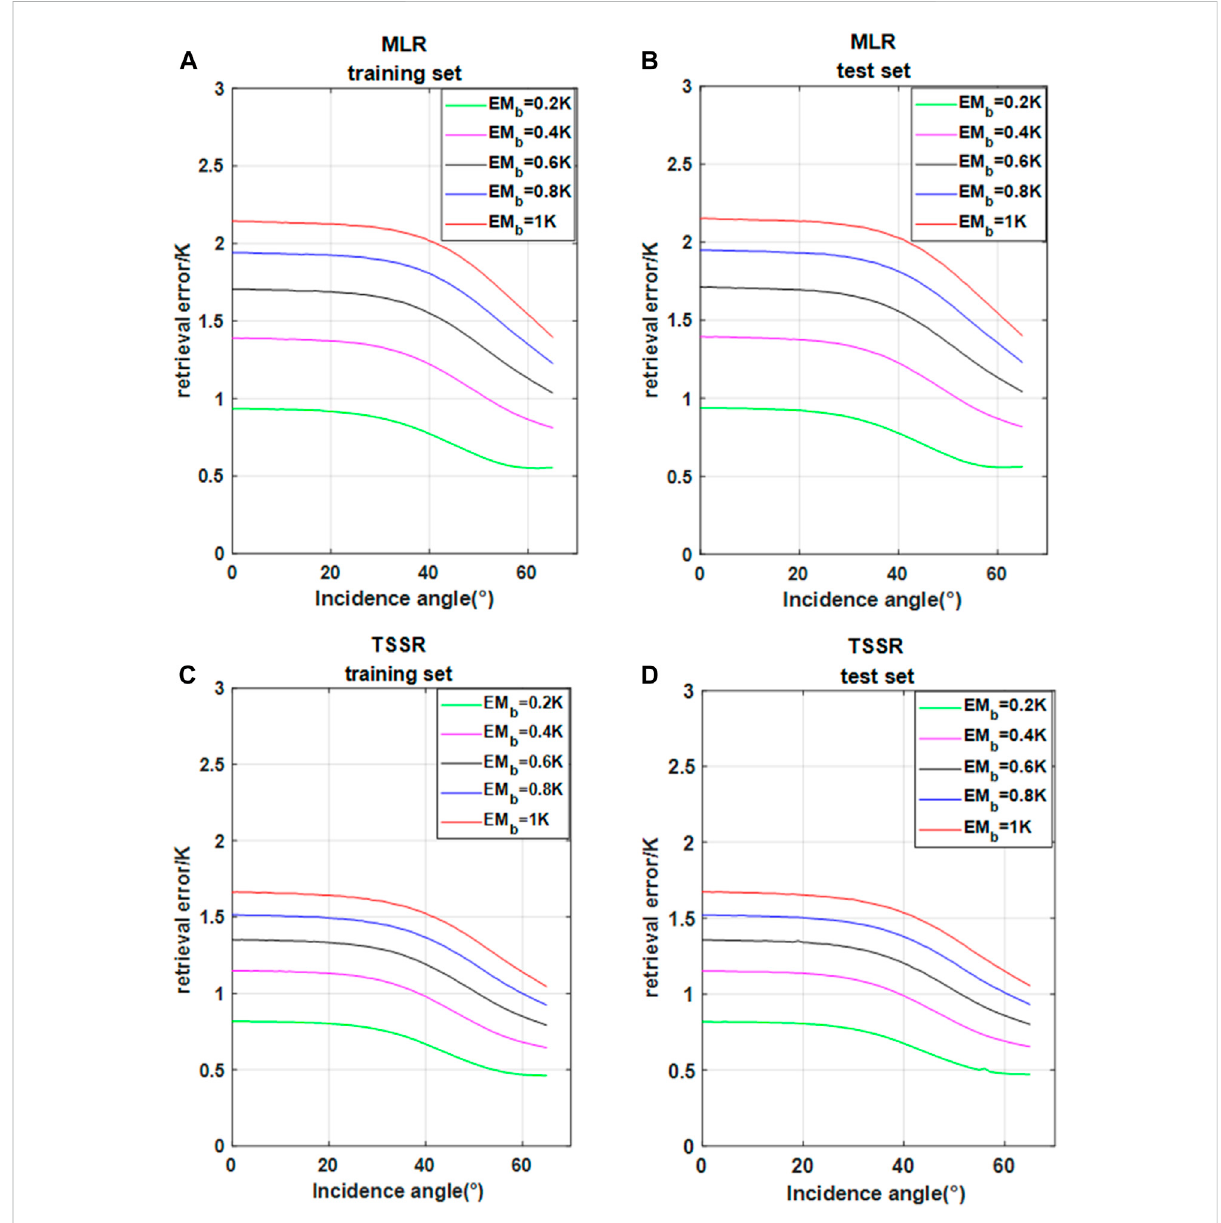
FIGURE 6 Relationship between SST retrieval error and incidence angle for different EM b . (A,B) MLR train and test; (C,D) TSSR train and